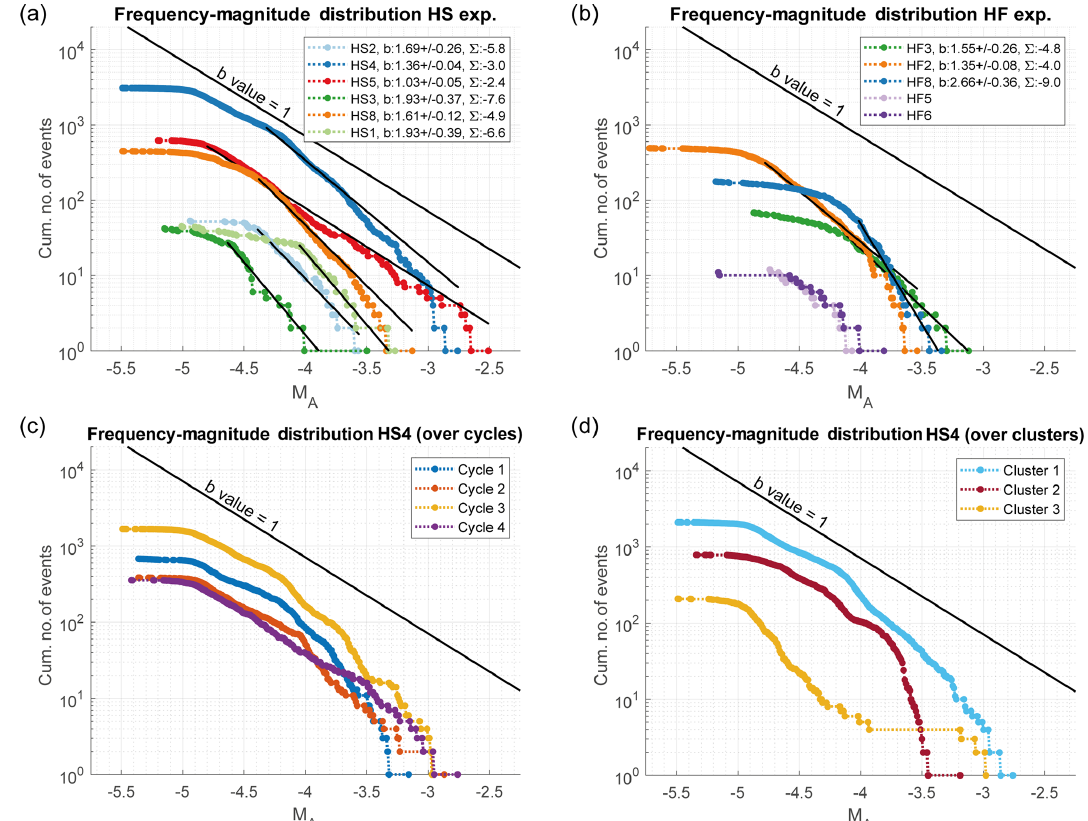
Figure 10. Frequency–magnitude distributions for the (a) HS and the (b) HF injection experiments along with estimated b values and seis- mogenic indices. Injection experiments in legends are ordered in a chronological manner, whereby HS injection experiments were performed in February 2017, and HF injection experiments were executed in May 2017. Frequency–magnitude distributions for injection experiment HS4, resolved in (c) injection cycles (Cycle 1–Cycle 4) and (d) clusters, introduced in Sect. 4.2. Uncertainties in b values are estimated after Marzocchi and Sandri